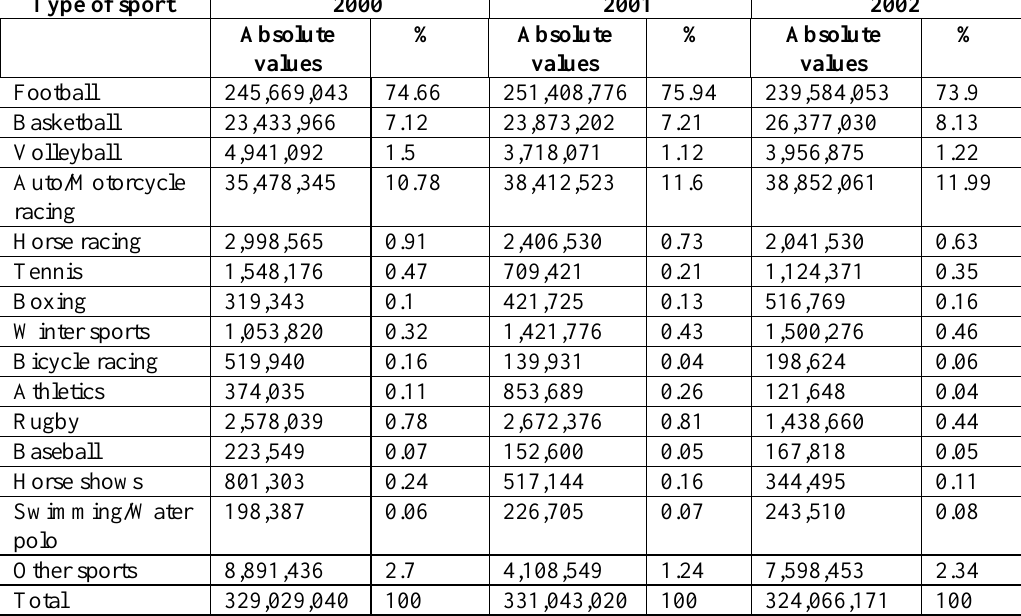
Figure 3: Expenditure in Italy for Sporting Events in 2002 (Values in